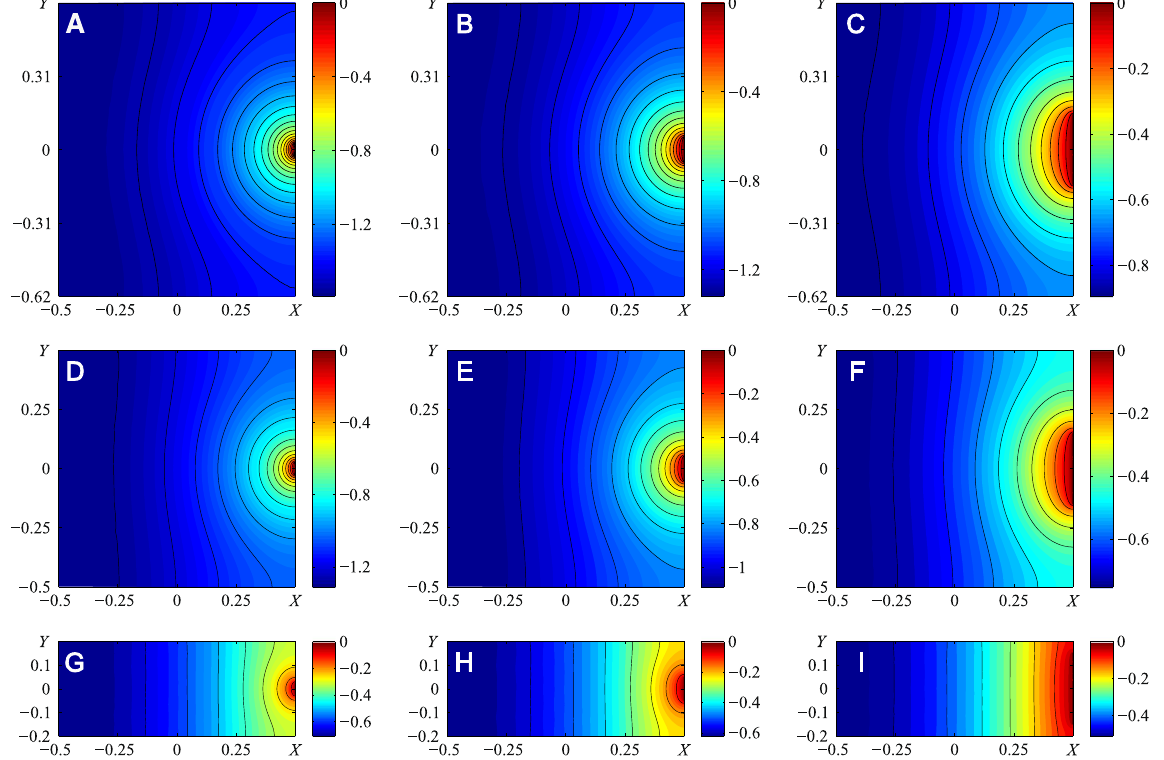
Figure 5. ( A – I ) Dimensionless pressure distribution P – K r for three different sizes of food canal diameter to chamber length ratios | AB |/L and three different sizes of chamber elongations W/L. Parameter W/L is equal to (1.24, 1, 0.4) for the three rows from top to bottom, and parameter | AB |/L is equal to (0.05, 0.1, 0.3) for the three columns from left to right. The color bar sets the pressure level. Black lines indicate constant pressure; the two nearest lines have a dimensionless pressure difference of